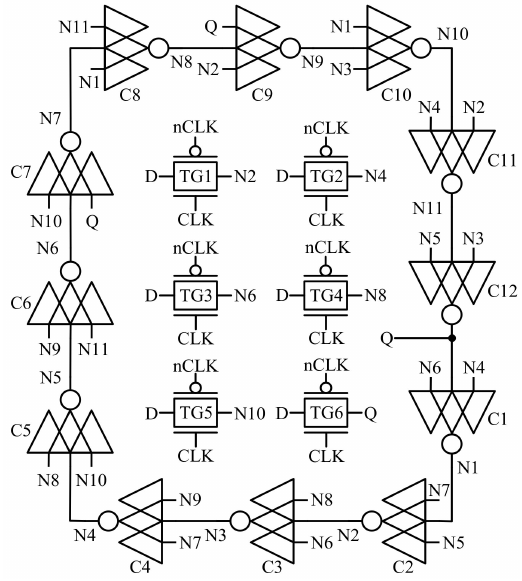
Figure 7. Schematic of LCTNURL